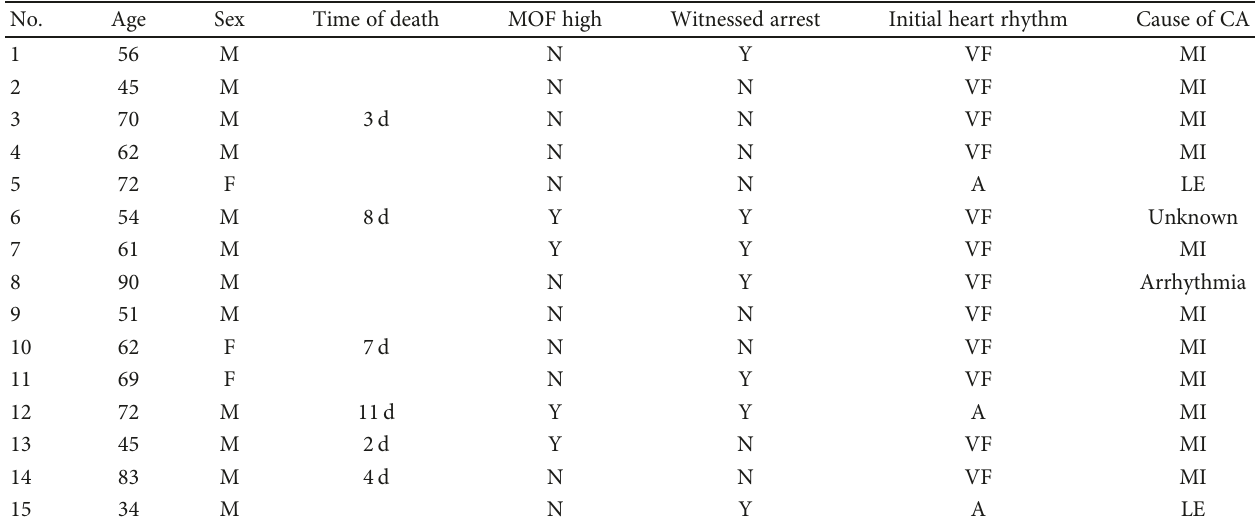
Table 1: Detailed clinical data ( n = 15 ).